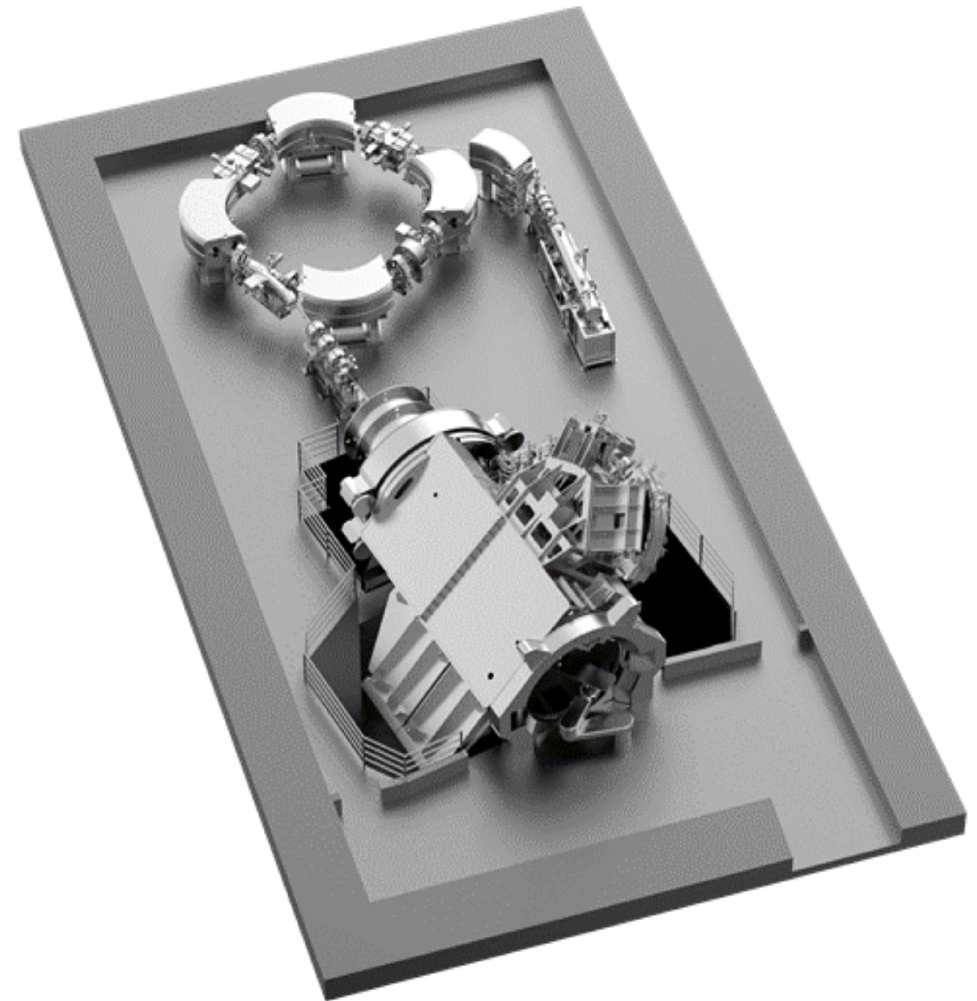
Figure 7. Model of the proton therapy technology proposed by Hitachi (courtesy of